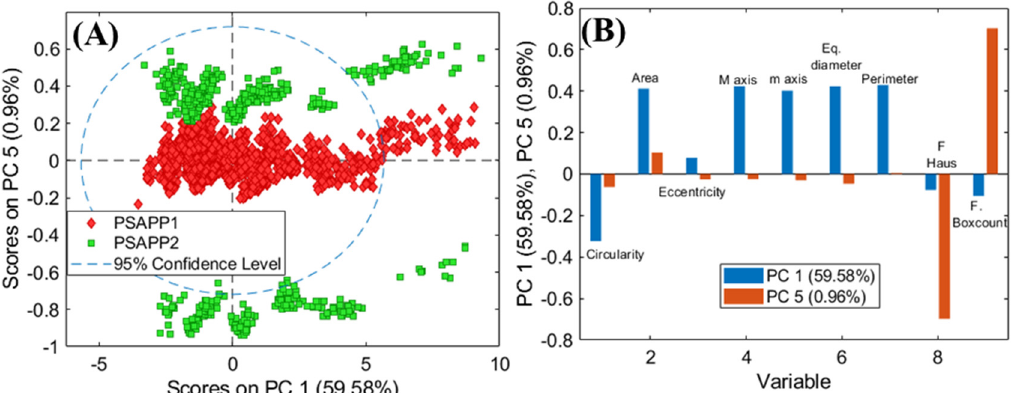
Figure 5. PCA score plot of PC1 and PC5 ( A ), and loadings ( B ) showing the variability of each selected parameter for the samples PSAPPB1 and PSAPPB2.